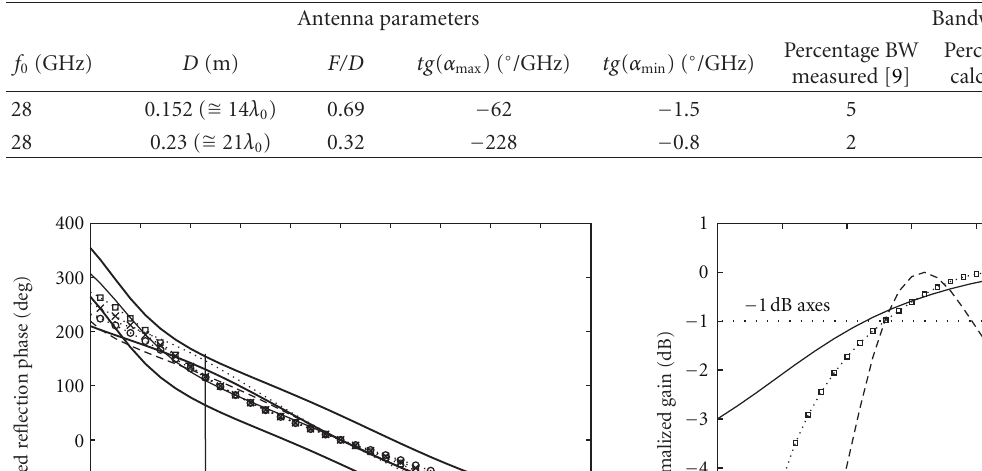
Table 1: Bandwidth estimation values compared to previously published data.